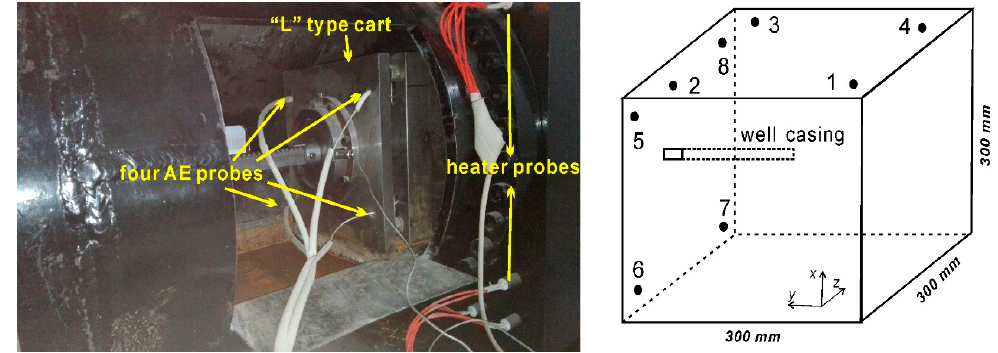
Figure 5. “L”-type